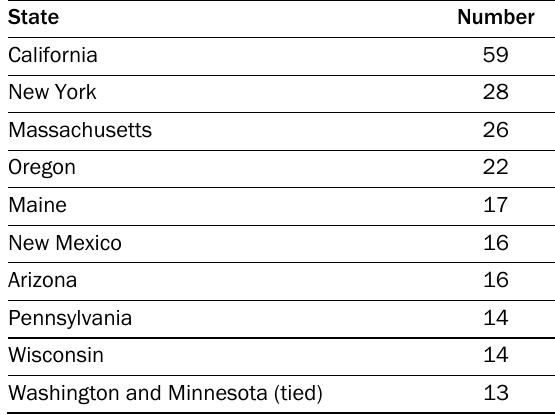
Table 1. Top 10 States by Number of